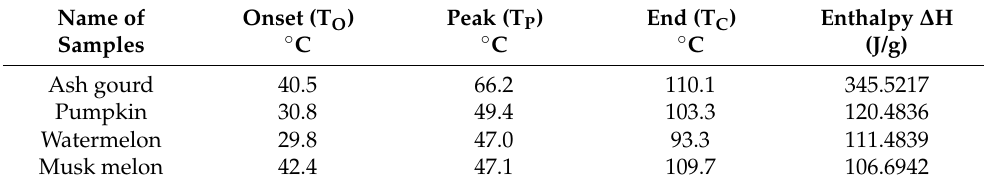
Figure 3. Thermal transition behavior of seeds. Numerous researchers have documented the thermal changes of the isolated protein, defatted flour and starch fractions of seeds because seeds have a complex composition (fat, protein, carbohydrate, minerals, etc.). The thermal profile of our investigated seeds is